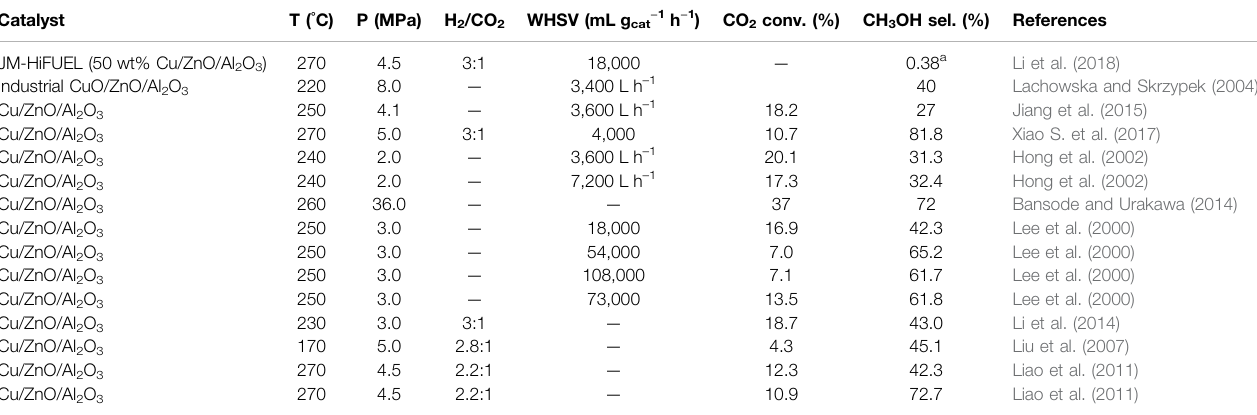
TABLE 1 | Performance of various Cu/ZnO/Al 2 O 3 ternary industrial catalysts.